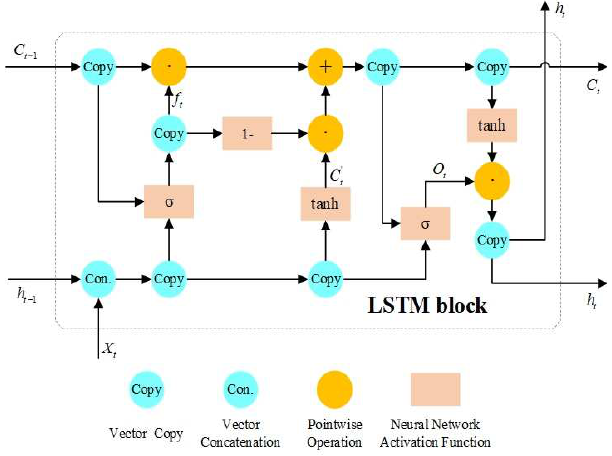
Figure 2. The structure of an LSTM